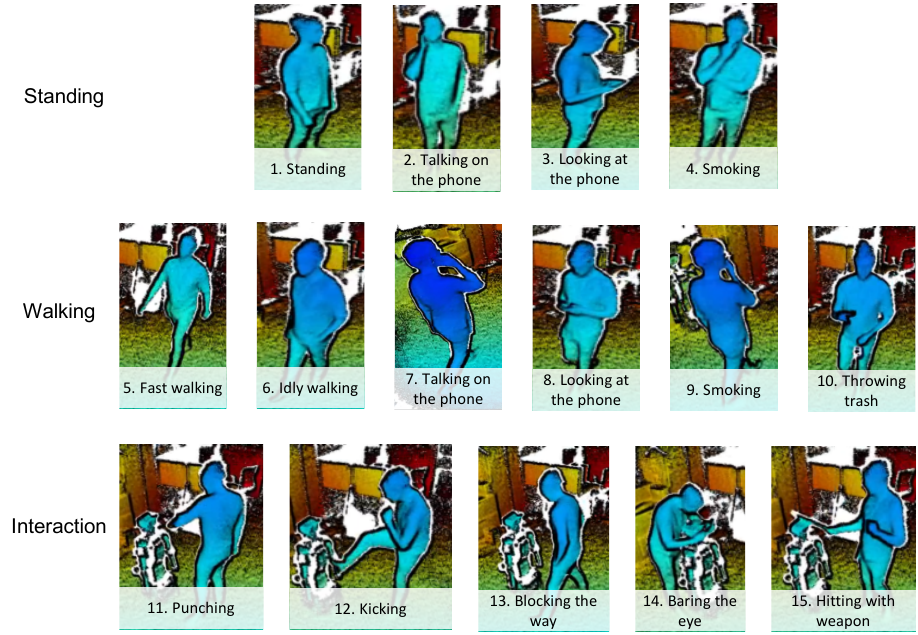
Figure 2. Collected actions in the Low-Moral Actions (LMA)